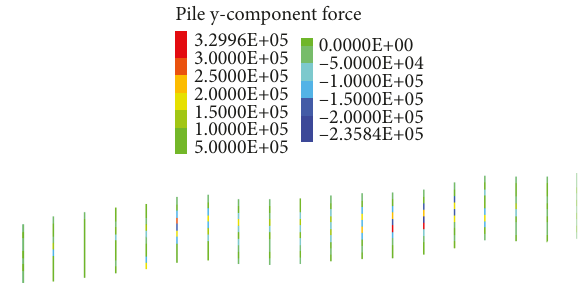
Figure 25: Pile shear force distribution under straight line layout.